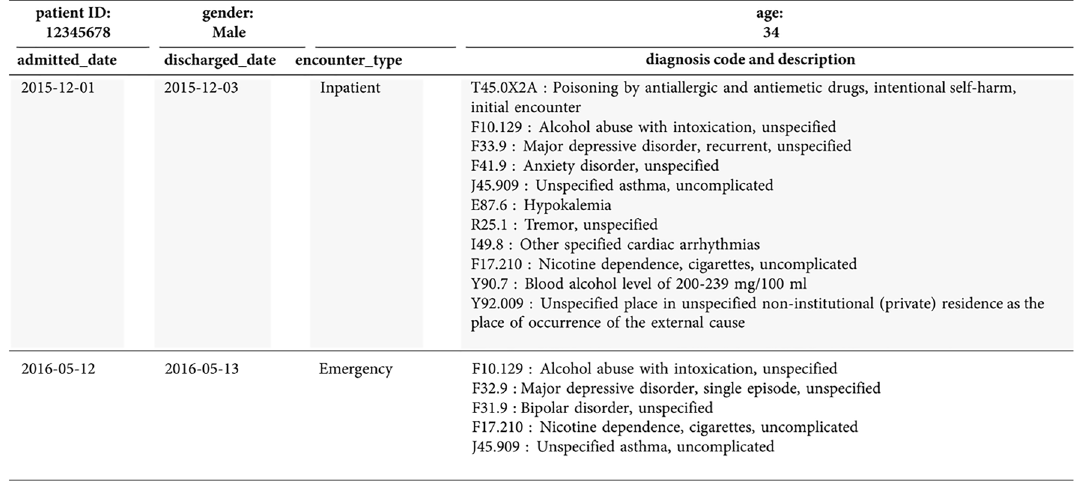
Figure 7. An illustration of a de-identified patient record presented to the clinical expert for